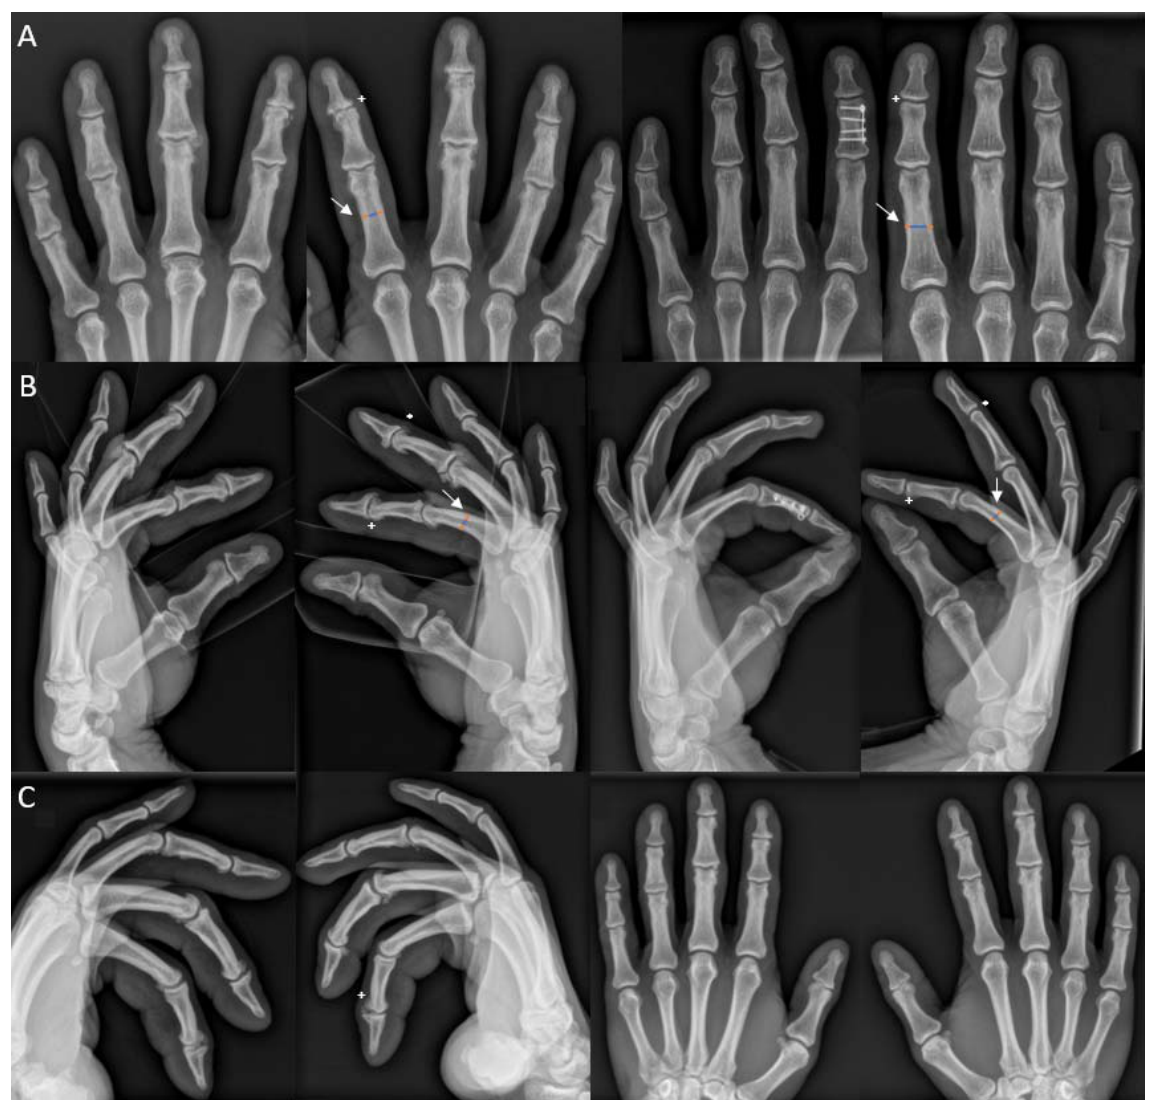
Figure 2. ( A , B ): Left: Radiographs of the participant. Right: Height- and weight-matched non- climbing male: ( A ): Anteroposterior radiographs of digits II–V of both hands. ( B ): Lateral radiographs of digits II–V of both hands. Note the thinner intramedullary canal (white arrow; blue line) and the thicker cortical bone (orange line) in the climber in contrast to the non ‐ climbing male. Furthermore, signs of osteoarthritis (e.g., right DIP digit II marked with +) and osteophytes (*) are demonstrated in the right digit II of the climber. More severe grades of osteoarthritis and bigger osteophytes are seen in fingers II and III. A normal DIP (+) without osteophytes (*) is demonstrated in the non ‐ climbing male with an incidental finding of a plate osteosynthesis in the middle phalanx of the left digit II after a fracture years ago. ( C ): The 10 ‐ year ‐ old lateral radiographs of digits II ‐ V and anteroposterior radiographs of digits II ‐ V of both fingers of the participant. Note the evolution of osteophytes over the course of 10 years (e.g., right DIP digit II marked with (+) in ( B )).